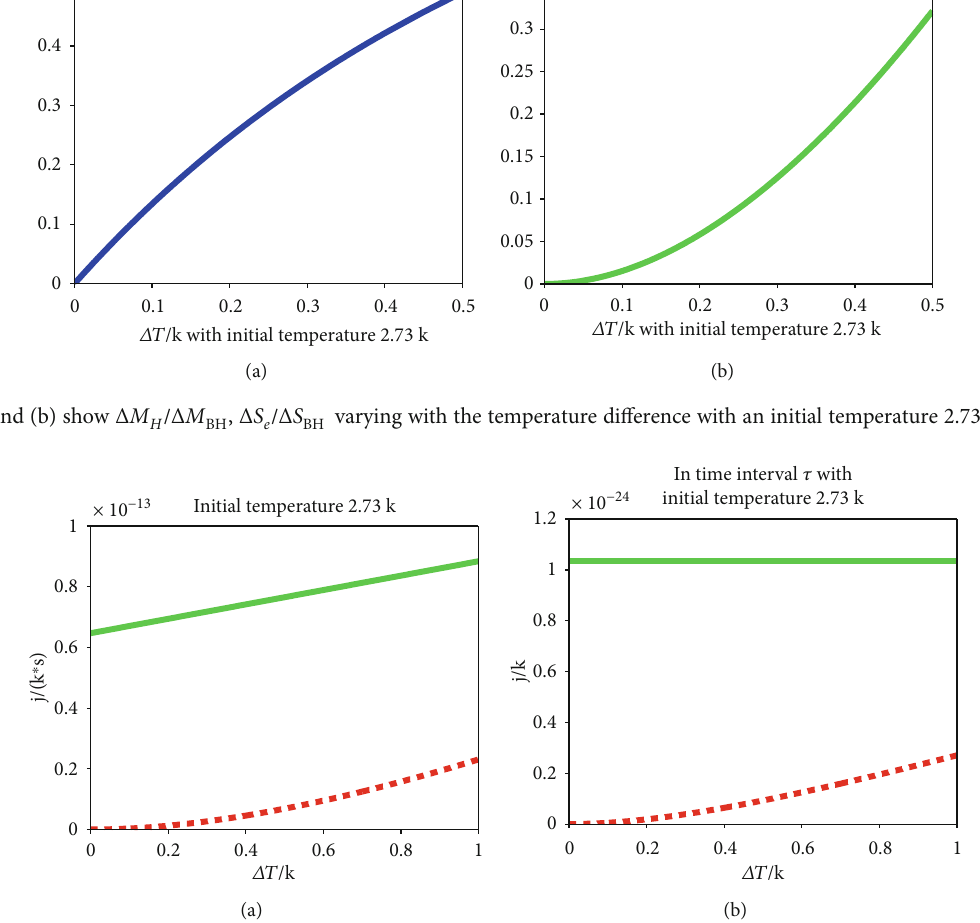
Figure 8: (a) shows the variation of the irreversible entropy production rate (red line) and the rate of entropy change of the black hole (green line) with respect to the temperature di ff erence with an initial temperature 2.73k. (b) shows the entropy change caused by irreversible entropy production (red line) and the entropy change of the black hole caused by radiation (green line) against the temperature di ff erence with an initial temperature 2.73k in time interval τ